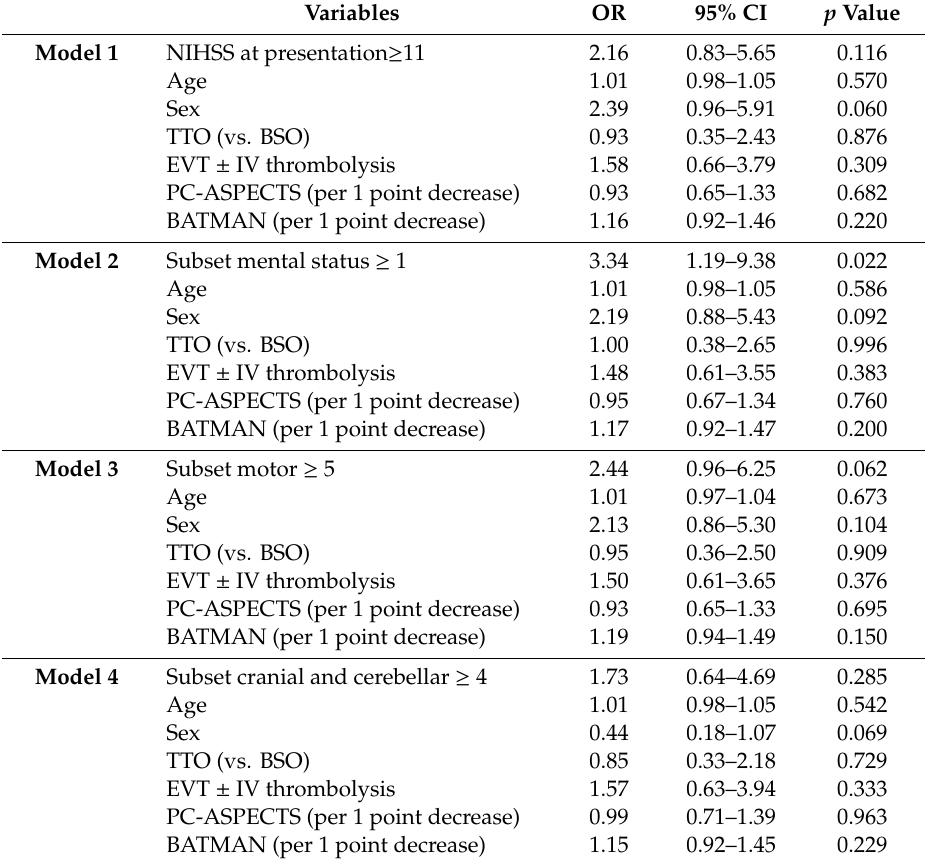
Table 2. Comparison of logistic regression models for predicting infarct growth using cut-o ff values generated by NIHSS and its subset